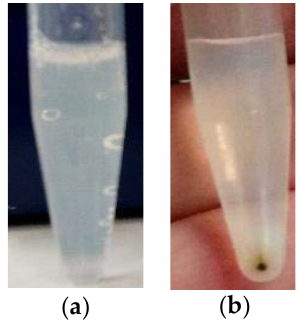
Figure 4. Representative images of ( a ) Cuphen liposomes and ( b ) liposomes co-loading Cuphen and IONPs, after a centrifugation cycle of 15,000 g , 30 min.